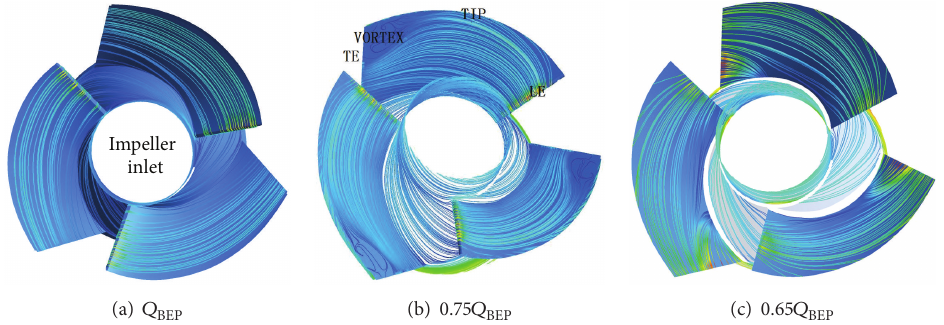
Figure 3: Velocity streamlines near the surface of impeller